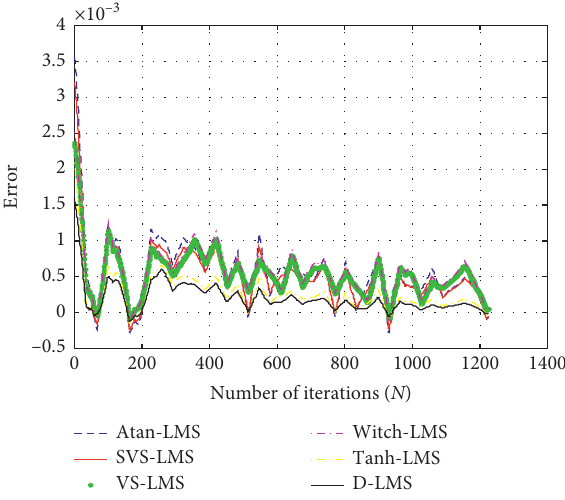
Figure 4: Error convergence curves of a few modified LMS